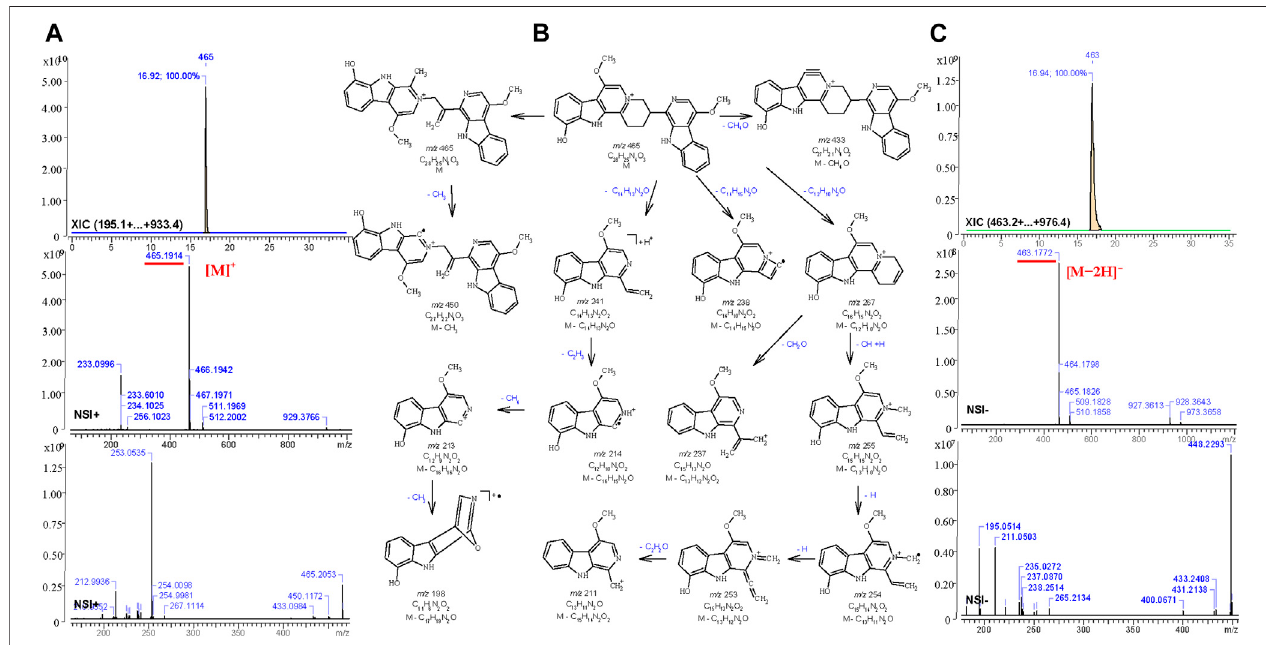
FIGURE 6 | Total ion chromatography analysis (XIC) and MS 1-2 spectra (A,C) of quassidine K (13) in the positive ( m / z 465.1914, [C 28 H 25 N 4 O 3 ] + ) and the negative ( m / z 463.1772, [C 28 H 23 N 4 O 3 ] - ) ion mode, and its main mass fragmentation pathway (B) in the positive ion mode generated by MS Fragmenter.